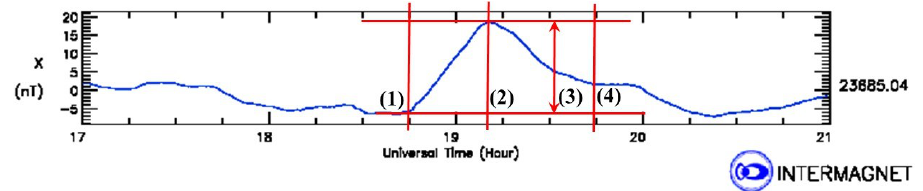
Fig.8. An example of the determination of the MPB parameters. We have chosen an isolated substorm, namely the one at 18:43 UT on 02 February 2013. The way of estimation the MPB parameters is presented on the plot from INTERMAGNET by straight lines, enumerated as follows: (1) time of the substorm onset; (2) time of the positive bay maximum; (3) amplitude of the X-component; (4) time of the positive bay